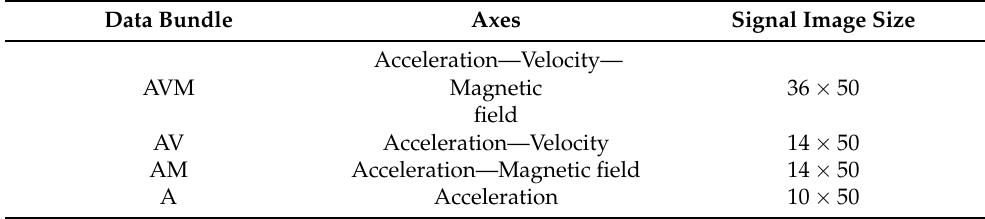
Table 3. Data bundles separately considered for the training of activity recognition models in this